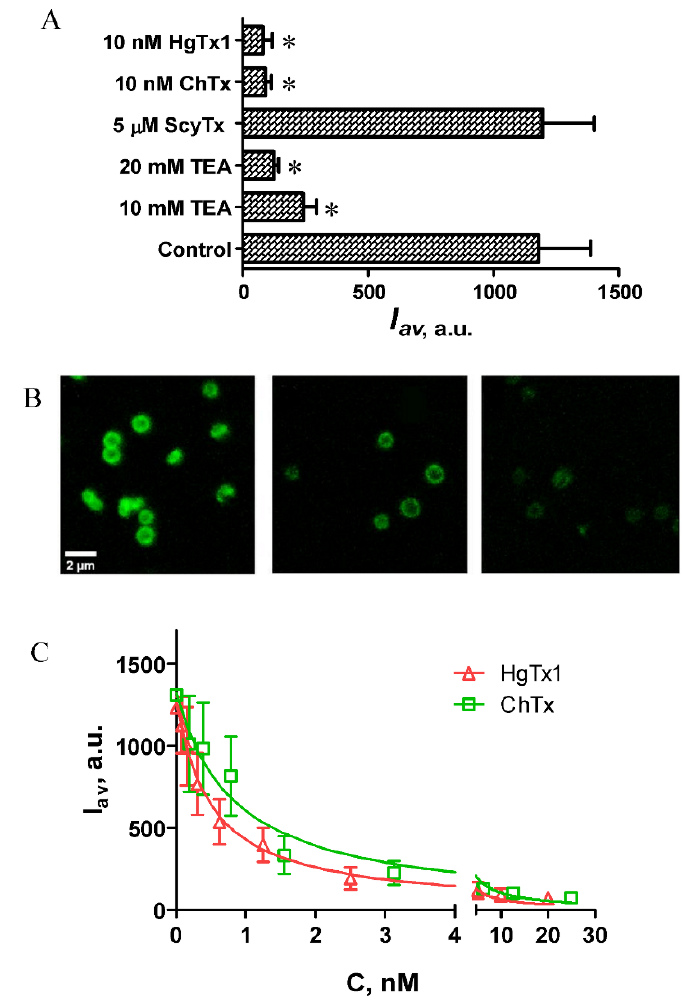
Figure 3. Competitive binding of GFP–MgTx and non-labeled peptide blockers to the Kv1.3 binding site. ( A ) Displacement of GFP–MgTx (30 nM) from the complexes with KcsA–Kv1.3 by HgTx1, ChTx, ScyTx and TEA. I av is an average intensity of fluorescence of GFP–MgTx associated with the surface of spheroplasts (mean ± SEM is shown; sampling size was >380 cells per point. The results were averaged over 3 independent experiments; *— p < 0.05). ( B ) Typical LSCM images of GFP–MgTx (30 nM) bound to KcsA–Kv1.3 at the spheroplast membrane in the presence of an increasing concentration of a non-labeled peptide blocker, for example, HgTx1. Concentrations of HgTx1 (left to right) are 0, 0.16 and 2.5 nM. ( C ) Typical concentration dependences of the displacement of GFP–MgTx (30 nM) from the complexes with KcsA–Kv1.3 by HgTx1 and ChTx. Mean ± SEM is shown, sampling size was >120 cells per point.